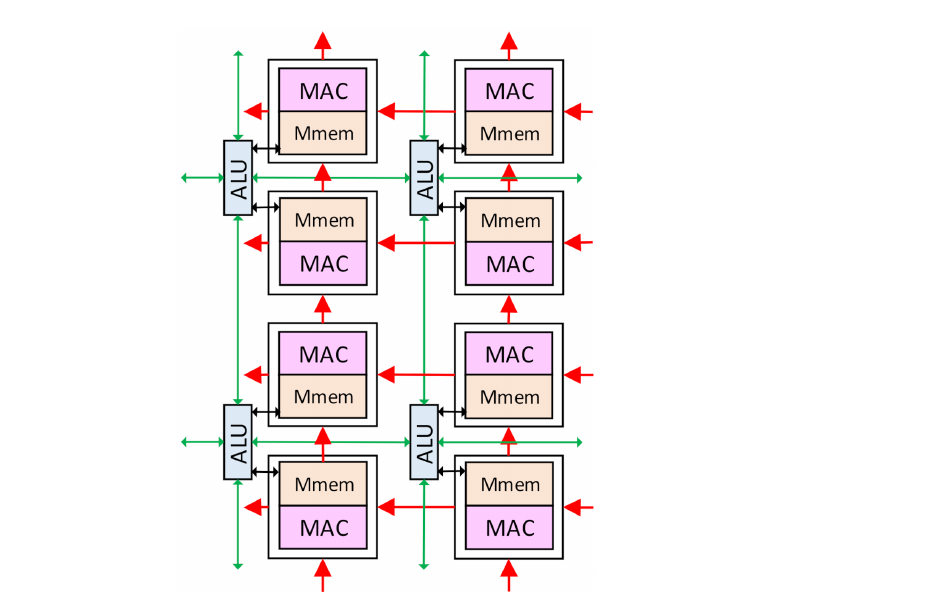
Figure 3. The overall architecture of the VPU.